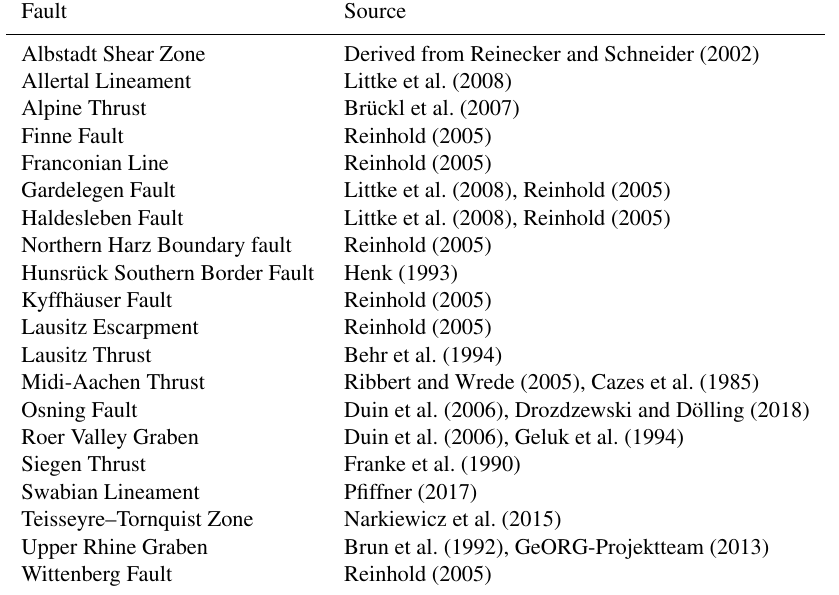
Table 1. Sources with suitable geological and seismic cross sections for the generation of semi-realistic fault geometries and the specific faults they were used